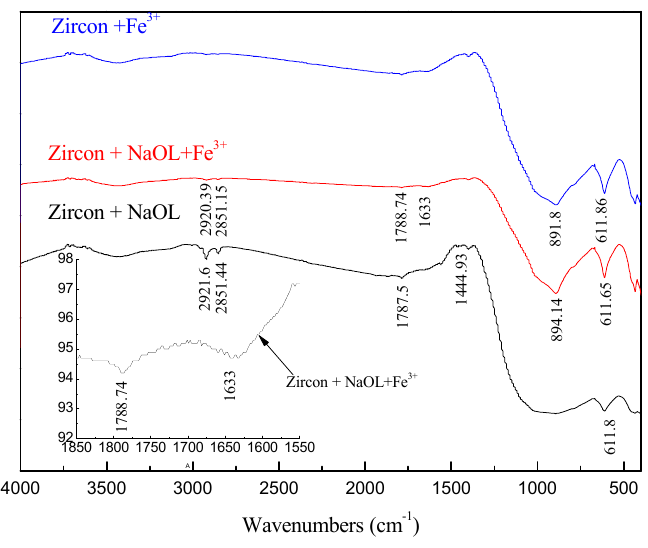
Figure 17. FTIR spectra of Zircon with NaOL and/or Fe 3+ at pH 8 (NaOL: 4 × 10 − 4 mol/L; Fe 3+ : 8 × 10 − 5 mol/L).